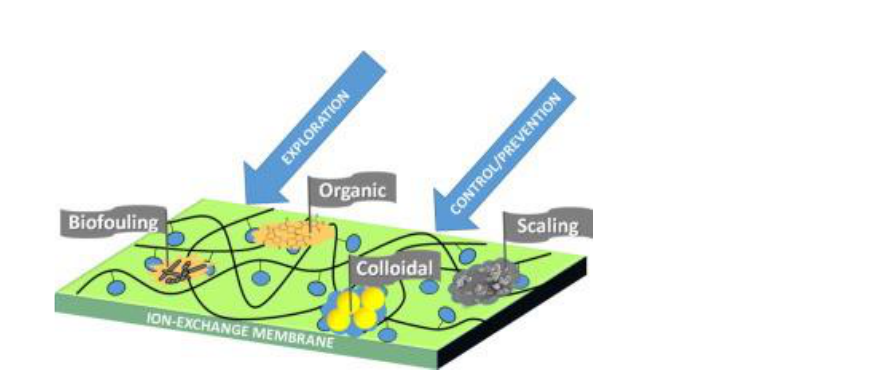
Figure 2. Types of fouling. Reprinted with permission from [28]. Copyright © 2015 Elsevier B.V.